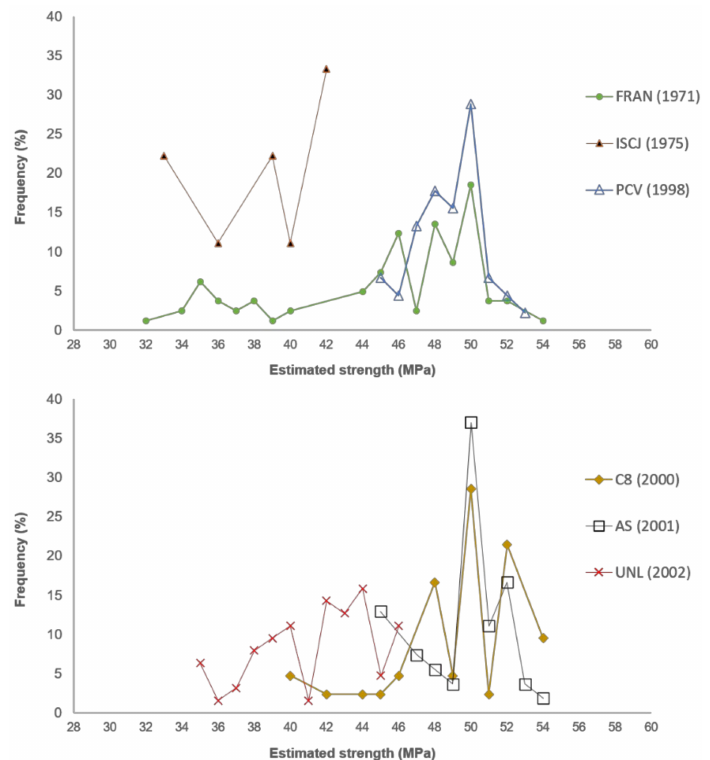
Figure 8. Frequency results of Schmidt rebound tests on architectural concrete